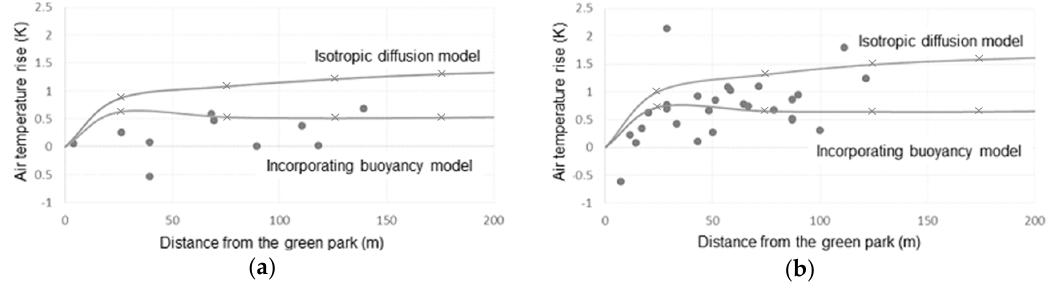
Figure 6. Calculation results and measurement results of air temperature rise at 17:00 according to the distance from the green area. ( a ) strong wind case; ( b ) weak wind case.